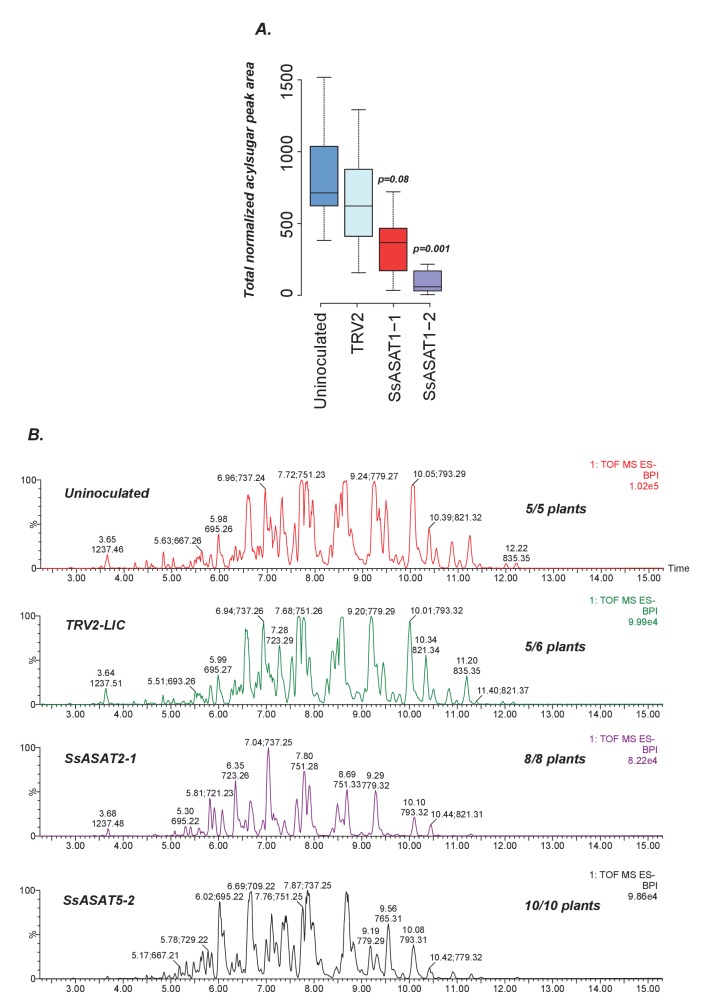
Results of knockdown of SsASAT1, SsASAT2 and SsASAT5 transcripts in a distinct replication of VIGS experiments.(A) SsASAT1 knockdown shows reduction of acylsugar levels. (B) SsASAT2 and SsASAT5 knockdown causes substantial changes in Salpiglossis acylsugar profiles. The accumulating acylsugars in these two knockdowns are different, as seen by the co-eluting m/z ratios. Number of plants showing depicted phenotype out of the total number of analyzed plants is noted on the right side of each chromatogram.